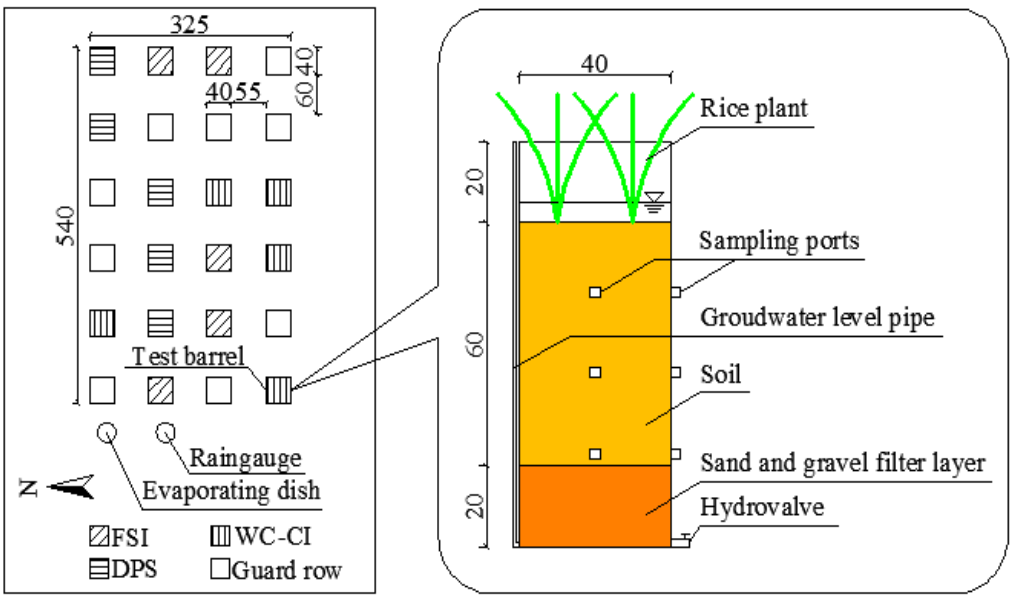
Figure 1. The experimental cell arrangement and test barrel structure.